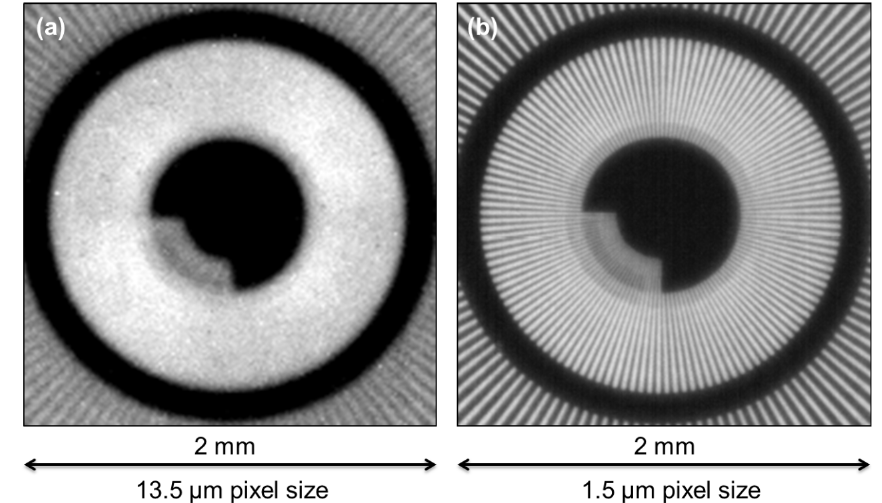
Figure 2. Comparison of the neutron radiographs of the gadolinium Siemens star test object based on (a) standard high-resolution neutron instrument (Kaestner et al., 2011a) and (b) the Neutron Microscope prototype (Trtik et al.,